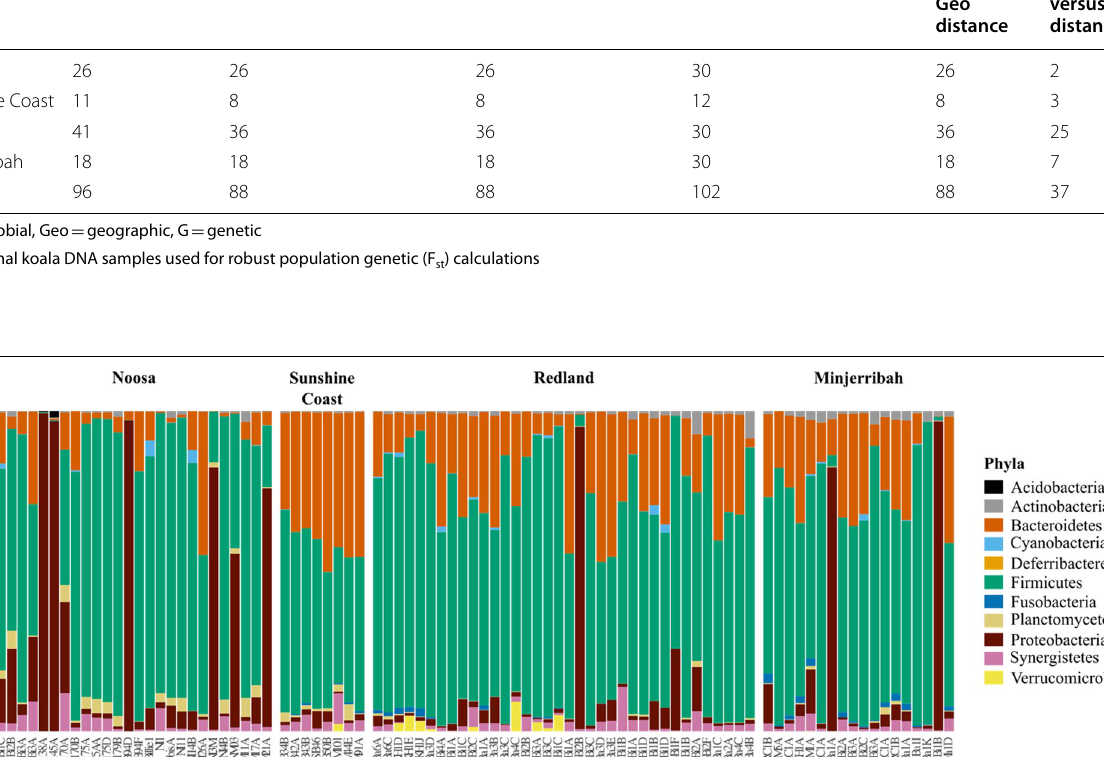
88). The gut microbiota of koalas was predominated by Bacteroides , =